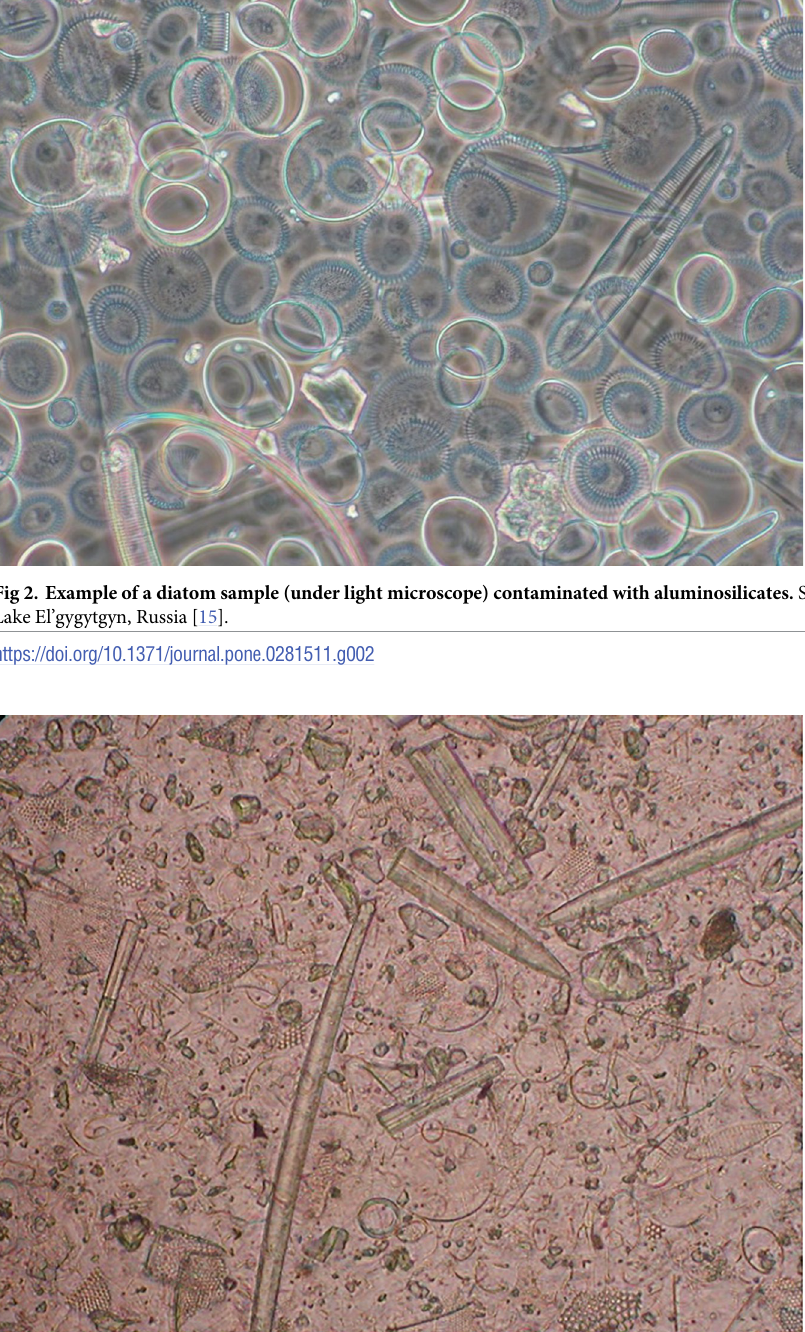
PLOS ONE | https://doi.org/10.1371/journal.pone.0281511 February 17,